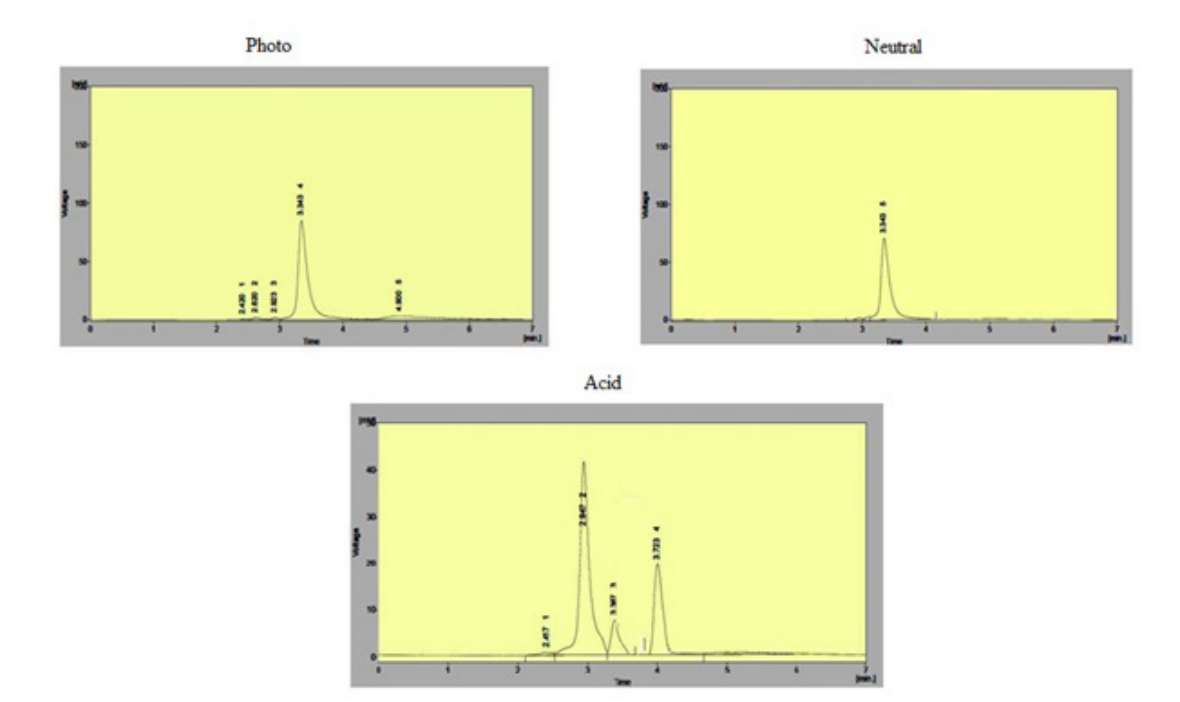
FIGURE 5 - Representative chromatogram of rutin in various degradation conditions.